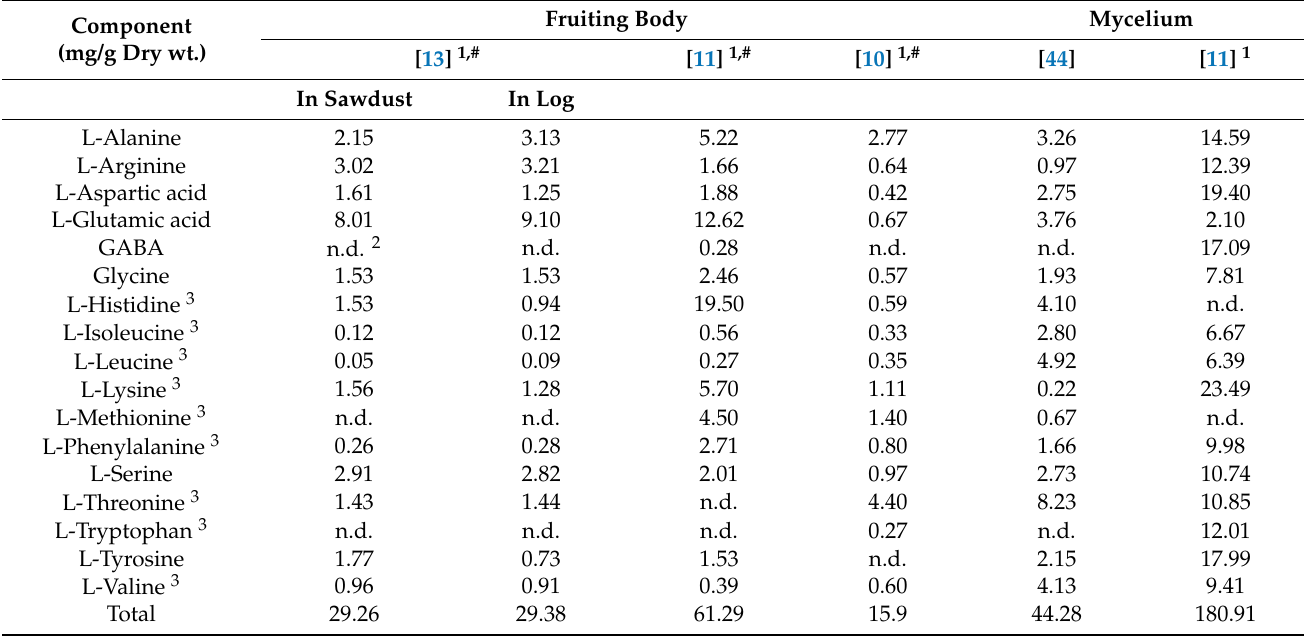
Table 3. Free amino acid assay of G. frondosa ’s fruiting body and mycelium in dry weight. Component (mg/g Dry